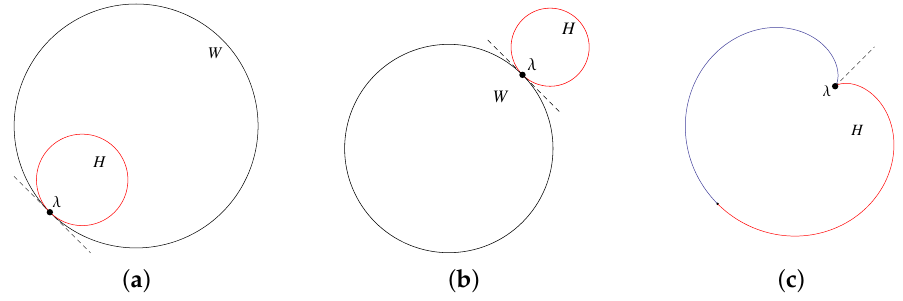
Figure 6. Typical bifucation geometries for satellite and primitive components. ( a ) inscription; ( b ) circumscription; ( c )